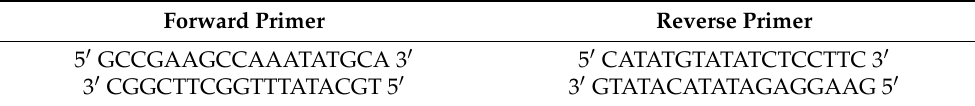
Table 1. List of 5 (cid:48) -phosphorylated primers. Forward